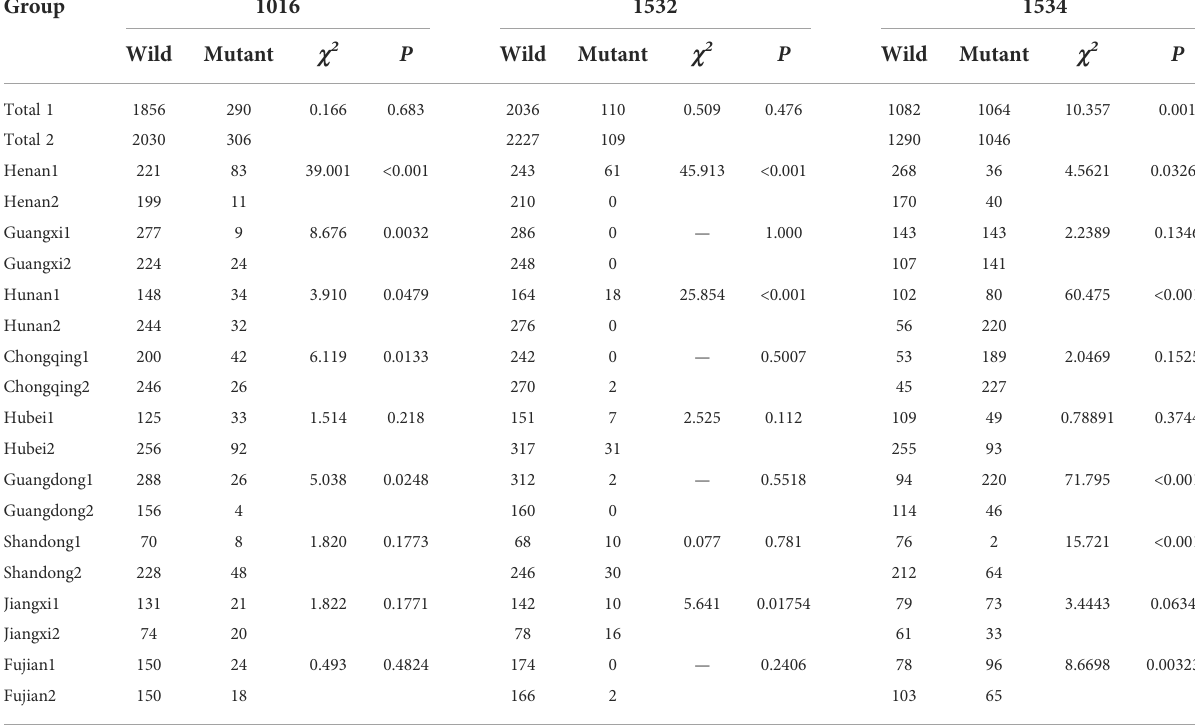
TABLE 3 Comparison of mutation rates between dengue epidemic areas and non-dengue epidemic areas. Group